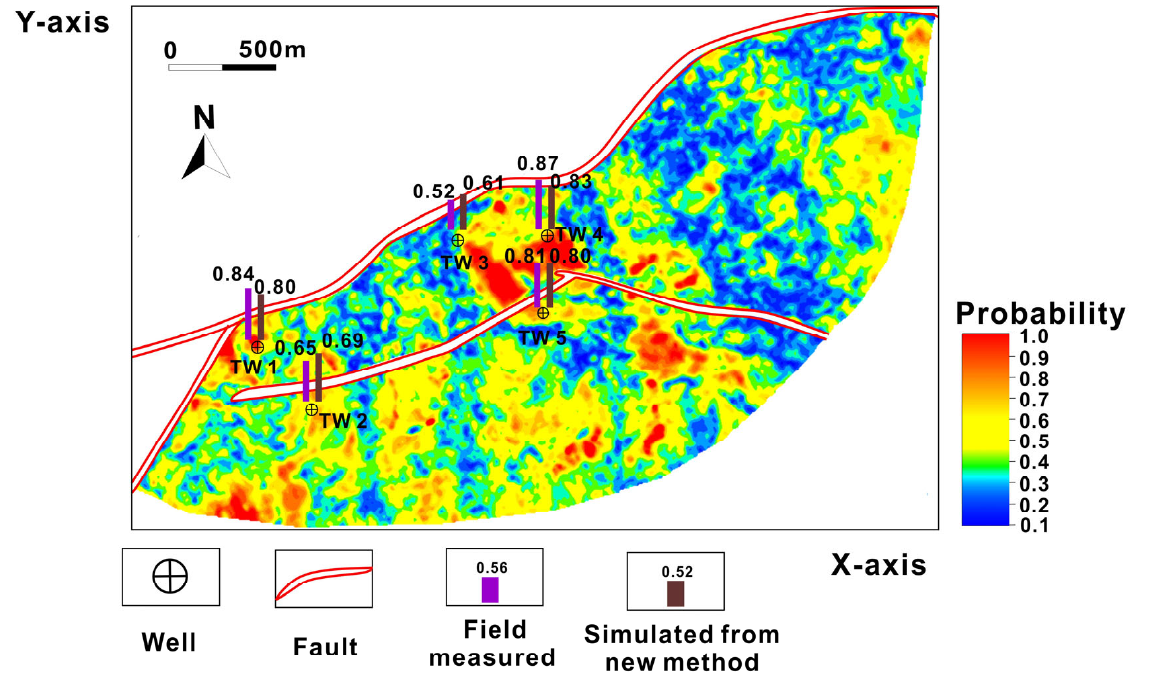
Figure 10. The sandbody development probability contour map of the target layer in the study area shows the relationship between the predicted development probability and the measured development probability of the verification well.